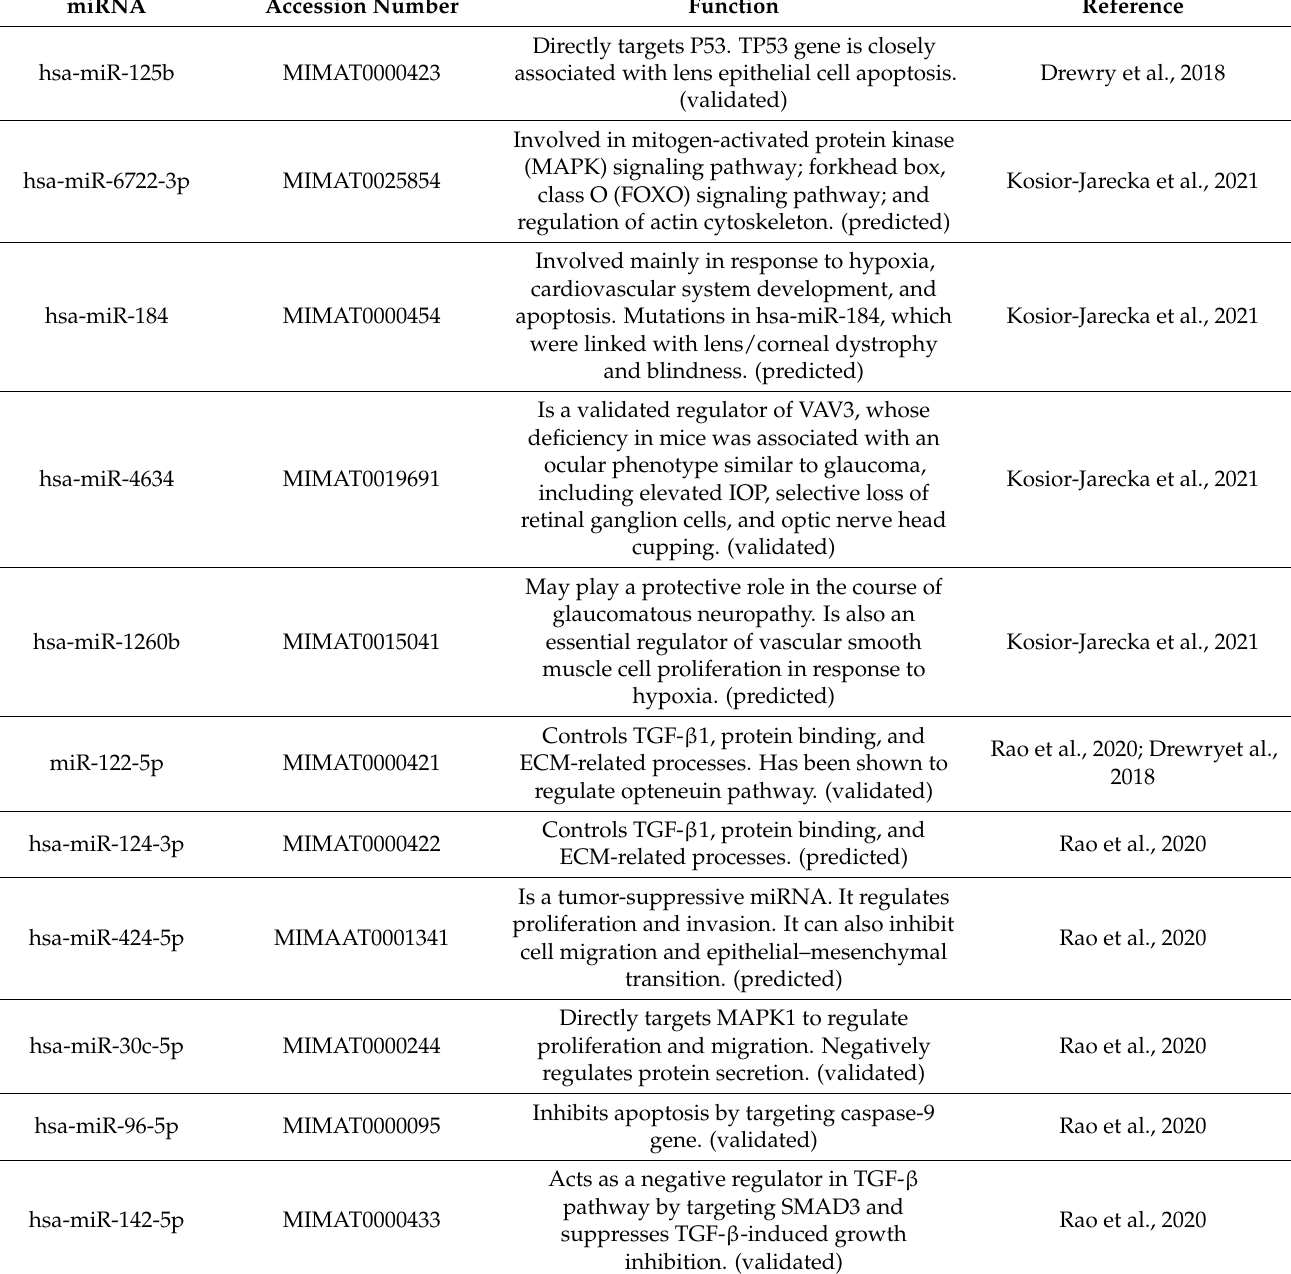
Table 1. List of miRNAs identified in exfoliation syndrome (XFS) and exfoliation glaucoma (XFG) and their